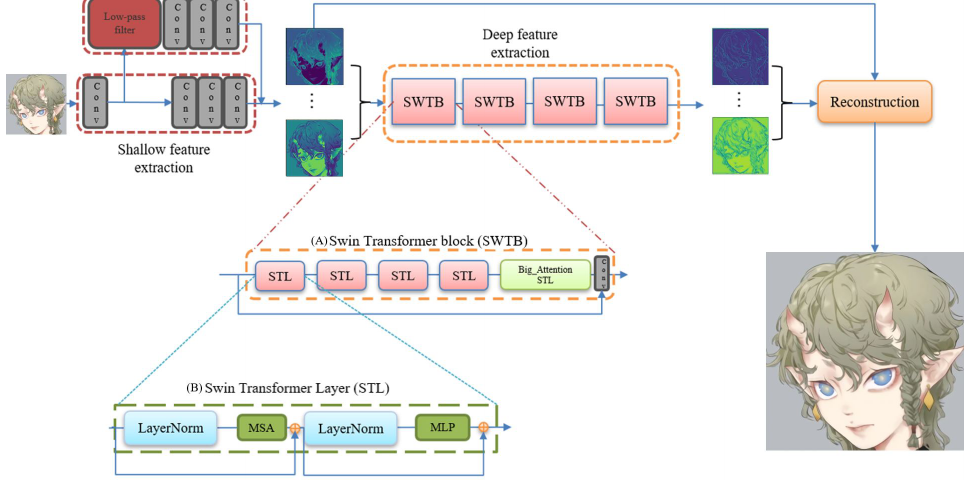
Figure 5. Overall network